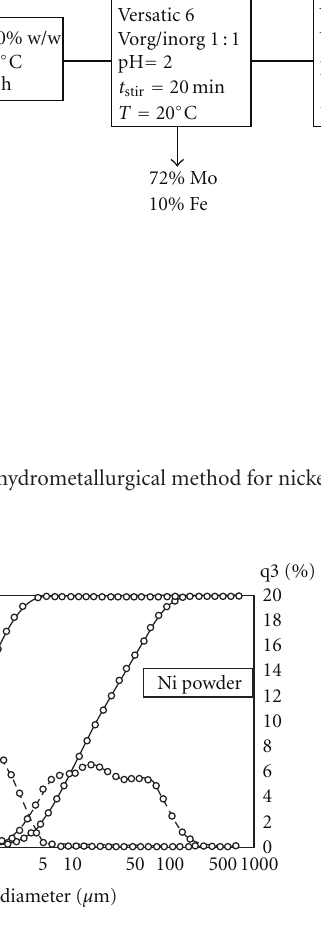
Figure 2: Particle size distribution of nickel and alumina powders.